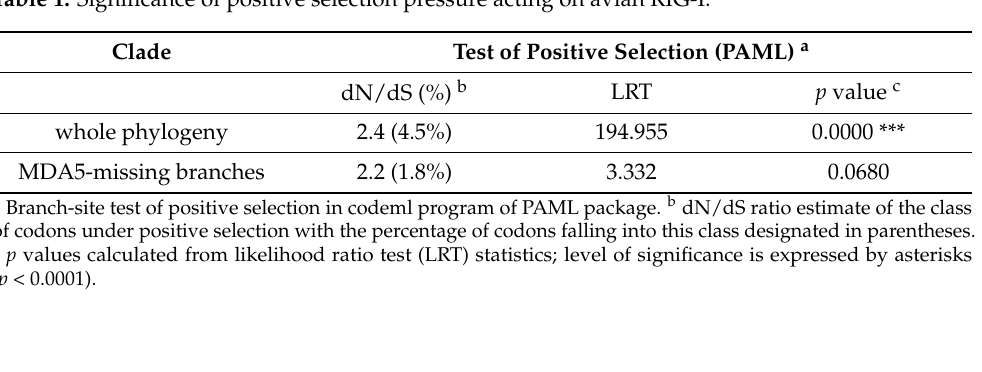
Table 1. Significance of positive selection pressure acting on avian RIG-I.